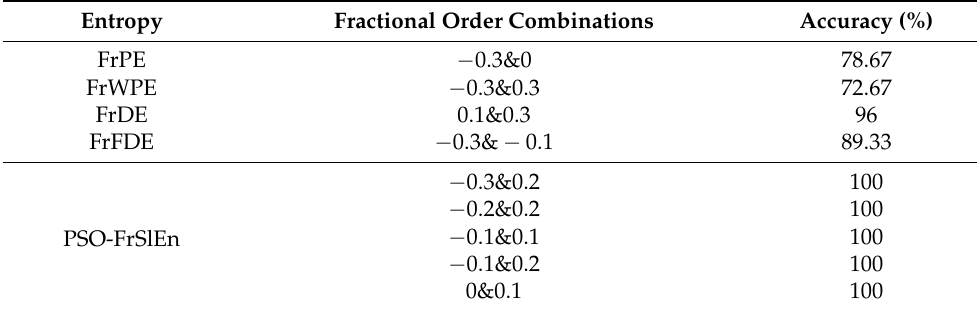
Table 2. The highest accuracy of each entropy under different double feature combinations. Entropy Fractional Order